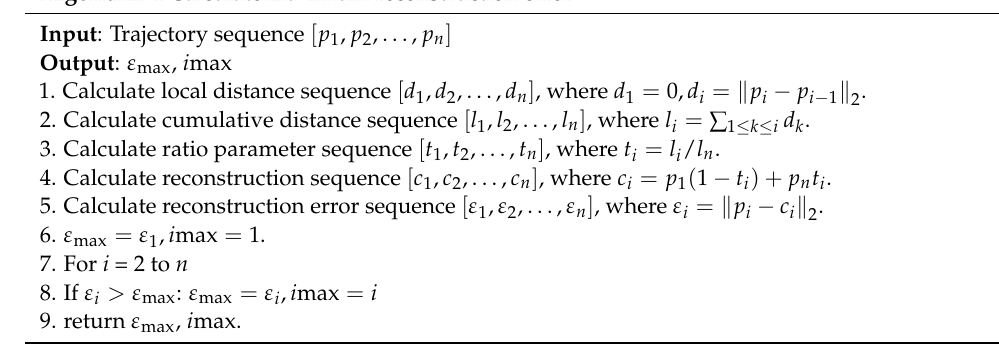
Algorithm 1 Calculate maximum reconstruction error